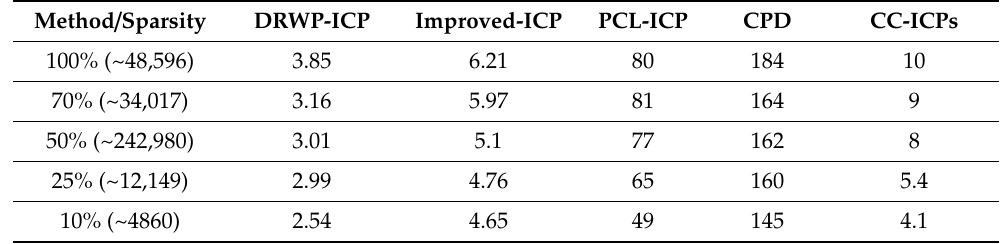
Table 2. Alignment times (seconds).